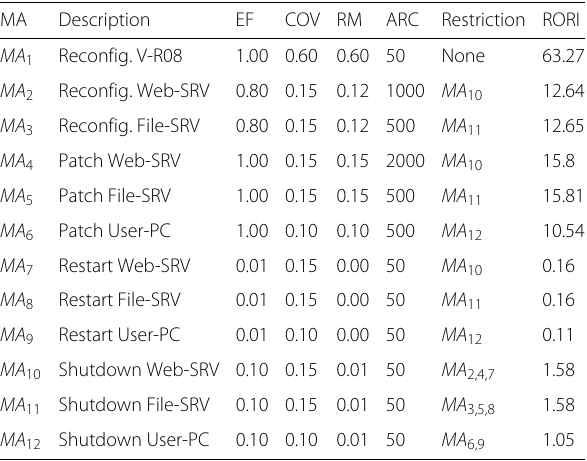
Table 3 Examples of RFIA evaluations for proposed response plans RP i consisting of a single mitigation action MA i for threat scenario AS 02